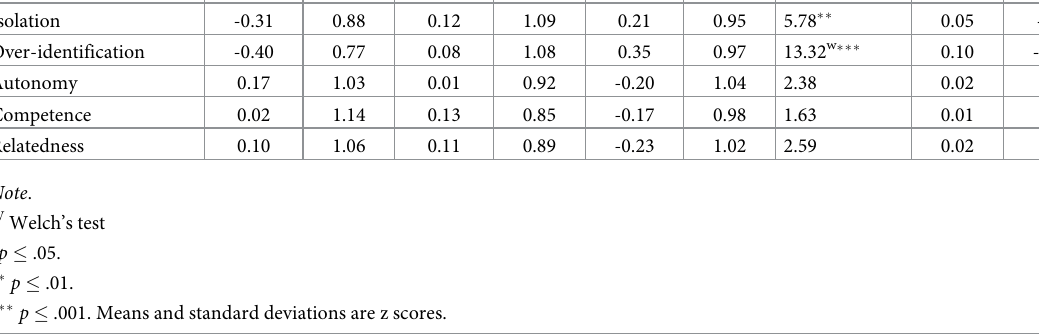
other groups. In addition, they showed a higher use of healthy strategies (self-kindness and